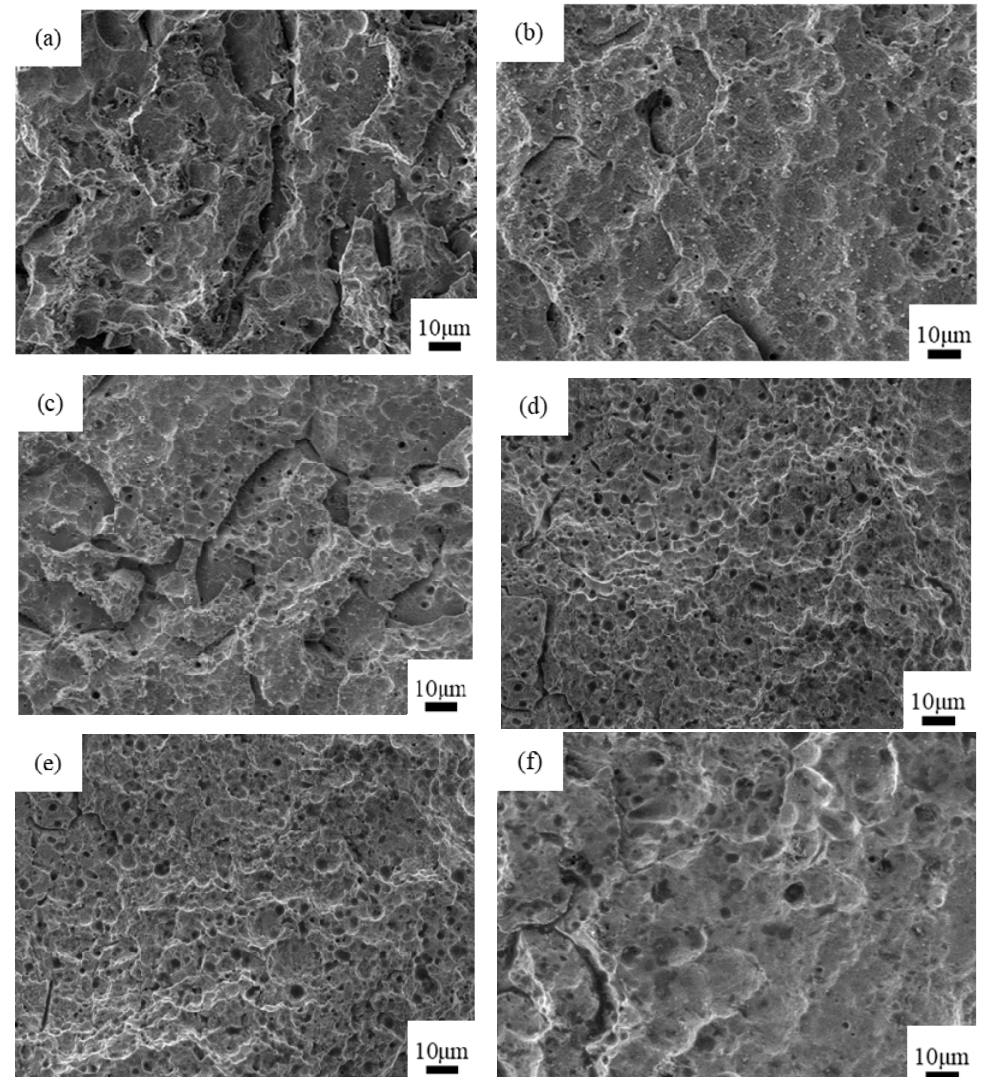
Figure 5. Micromorphology of the copper surface by SEM in six schemes. ( a ) Scheme 1; ( b ) Scheme 2; ( c ) Scheme 3; ( d ) Scheme 4; ( e ) Scheme 5; ( f ) Scheme 6.